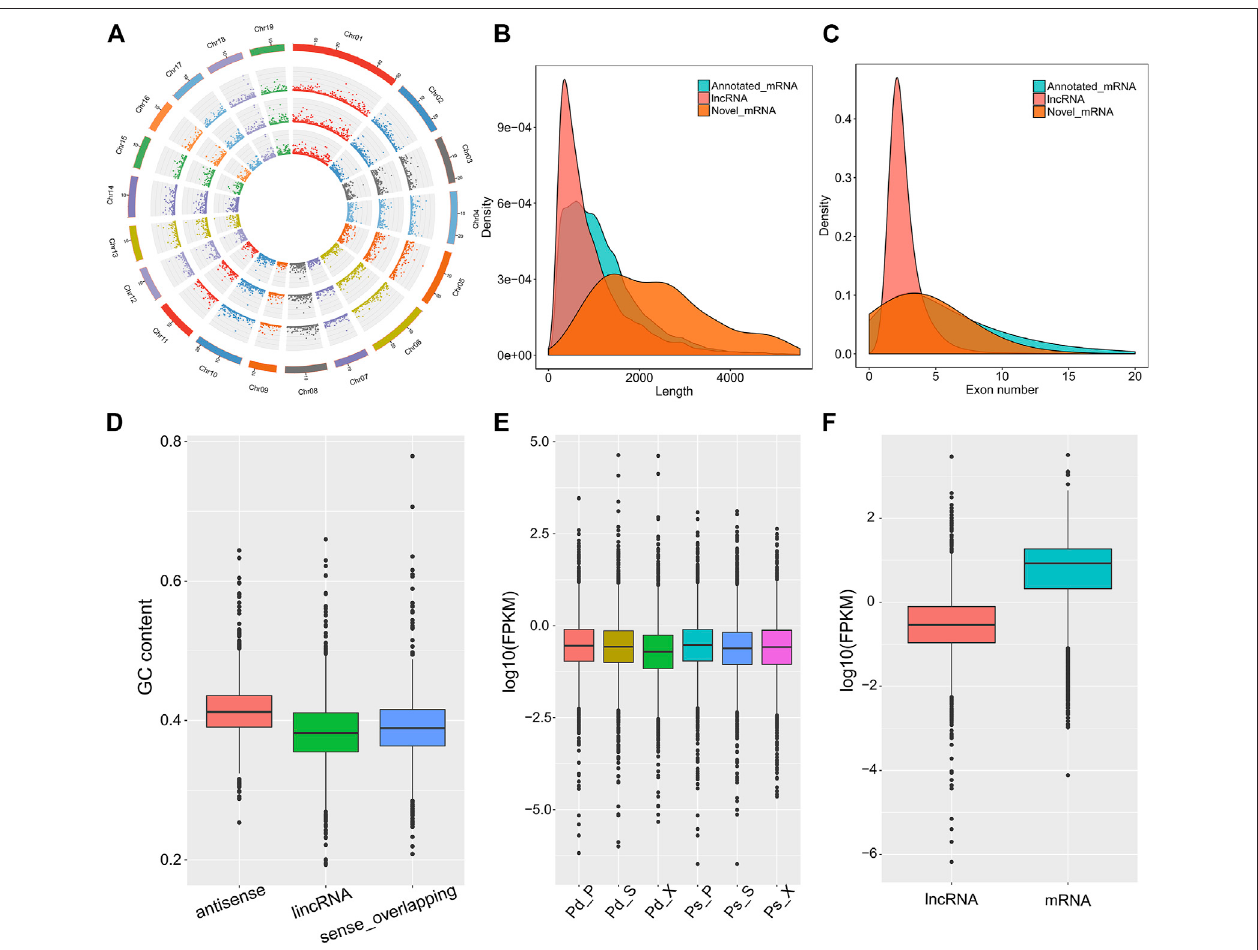
FIGURE 2 | Characterization of cassava lncRNAs in Pd and Ps. (A) Distribution of lncRNAs along each chromosome for the SAM, phloem, and xylem in Pd from insidetooutside. Distributionsoflength density (B) and exonnumbers (C) inmRNAs,novel mRNAs,and novel lncRNAs. (D) GCcontentoflncRNAs. (E) Fragments per kilobase per million read (FPKM) values of lncRNAs in different samples. (F) Comparison of the expression levels of lncRNA and